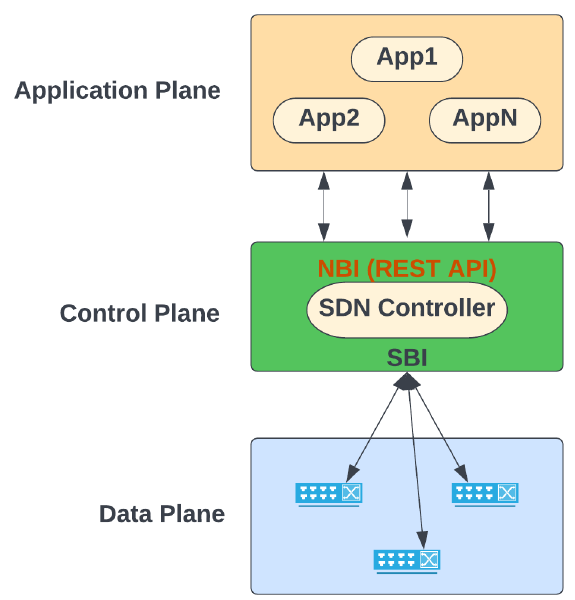
Figure 2. SDN General